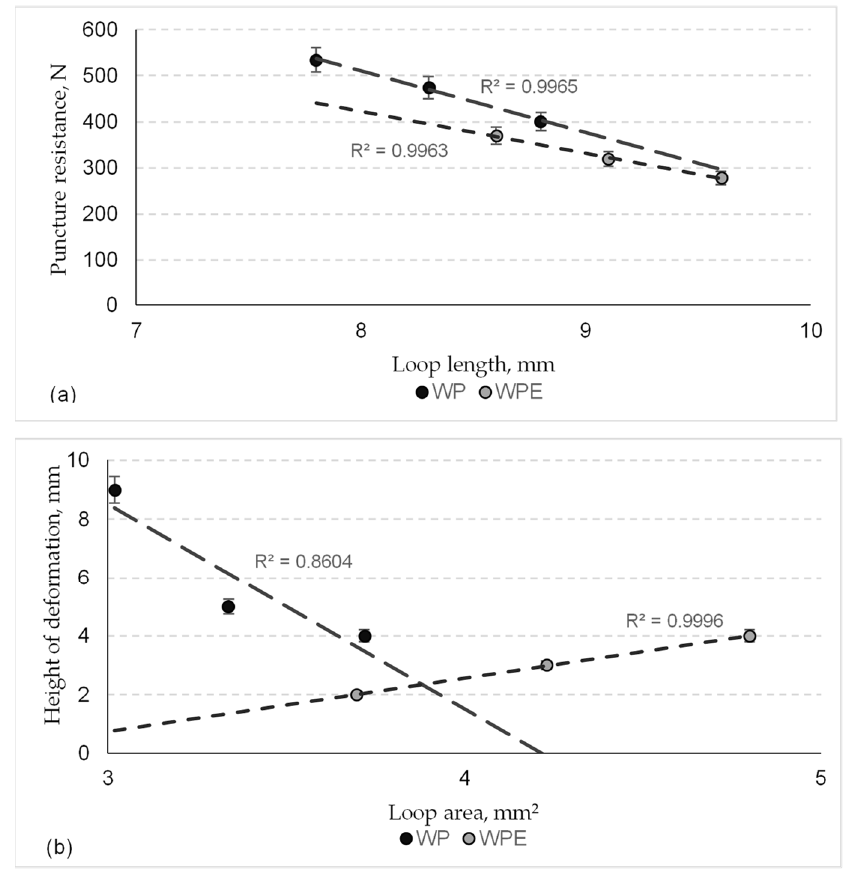
Figure 5. Puncture resistance ( a ) and height of deformation ( b ).